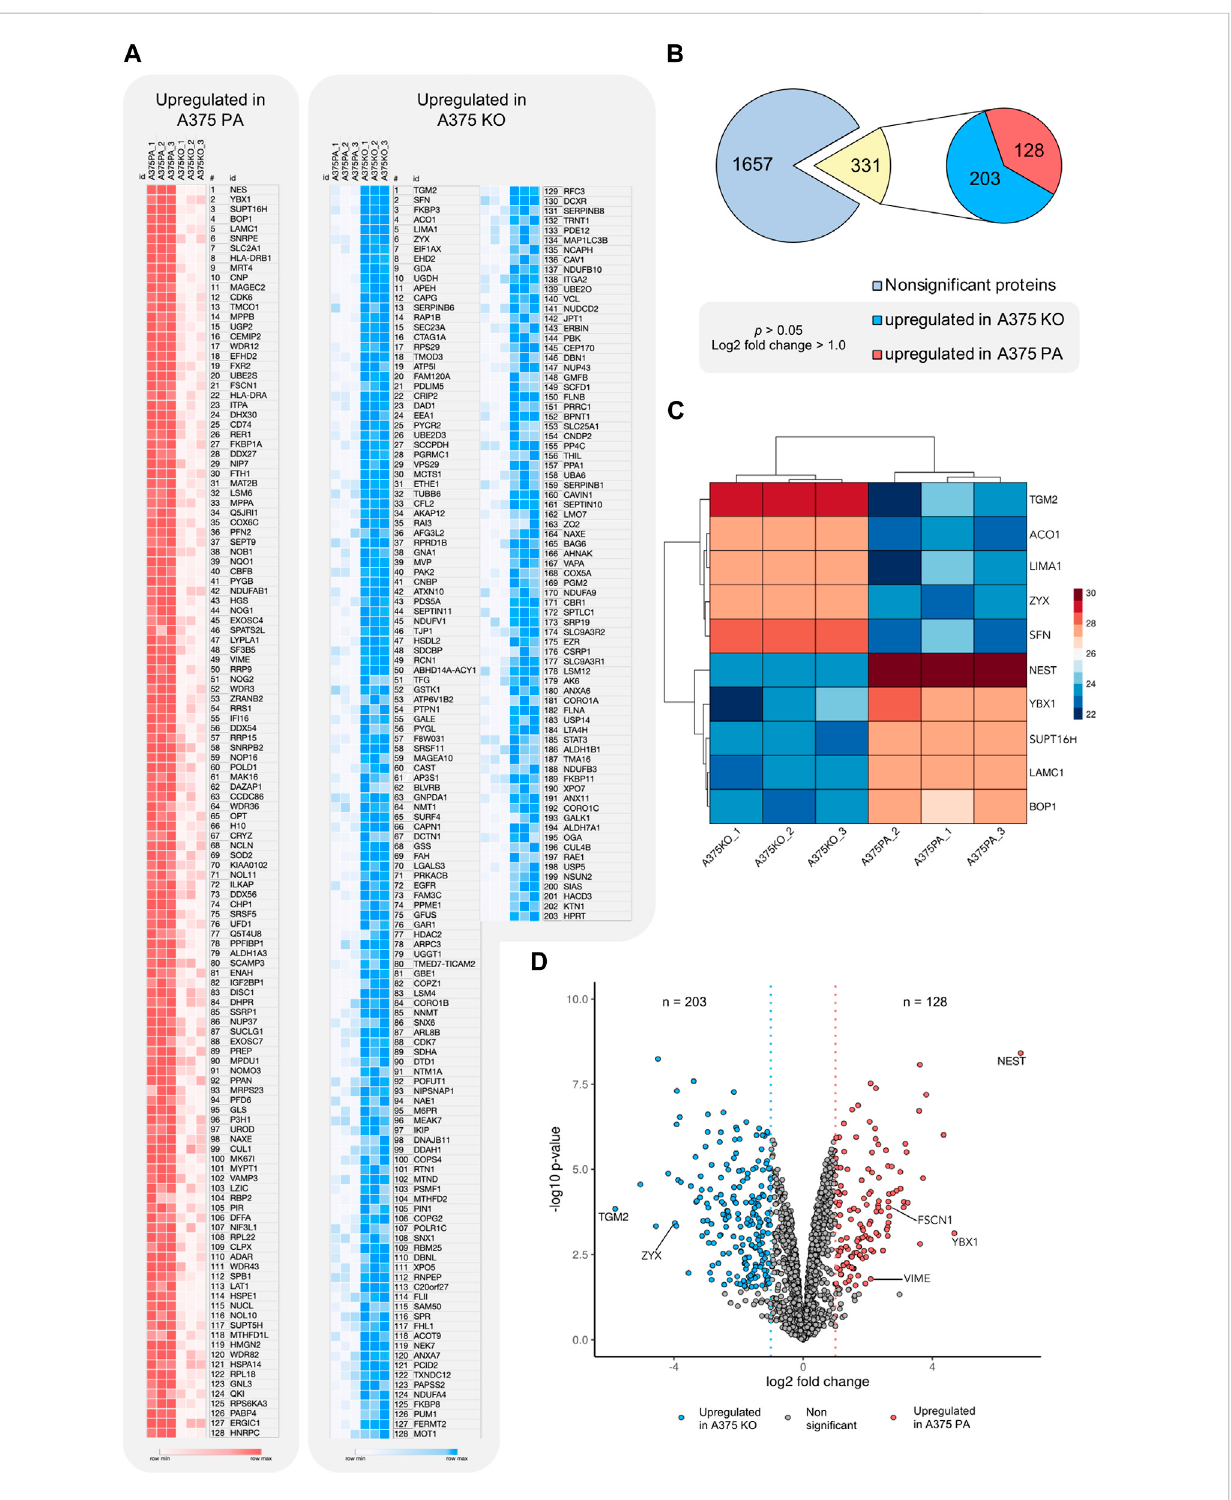
FIGURE 3 Visualization of signi fi cantly upregulated proteins in A375 parental and A375 YB-1 knock-out cell lines ( p > 0.05, cutoff log 2 fold change > 1.0) (A) A heatmap of log 2 transformed and imputed LFQ intensity values in A375 parental and A375 YB-1 knock-out (3 replicates per cell line) showing a complete list of signi fi cantly upregulated proteins in both cell lines ( p > 0.05). Proteins are sorted according to their size effect. Generated in Morpheus Matrix Visualization(https://software.broadinstitute.org/morpheus/). (B) Numericalvisualizationofthetotalnumberofproteinsidenti fi edintheproteomic analysis and the number of signi fi cantly regulated proteins. Out of 1657 proteins, statistical analysis revealed the total number of 331 signi fi cantly regulated proteins, of which 128 were signi fi cantly upregulated in A375 parental and 203 in A375 YB-1 knock-out cell line. (C) Clustered heatmap (completemethod)oftop5signi fi cantlyupregulatedproteinsinbothcelllinesshowingtheproteinswiththehighestmagnitudeofexpressioncompared to the other cell line. Columns in each cell line represent triplicates of log 2 transformed and imputed LFQ intensity values. Rows show the expression